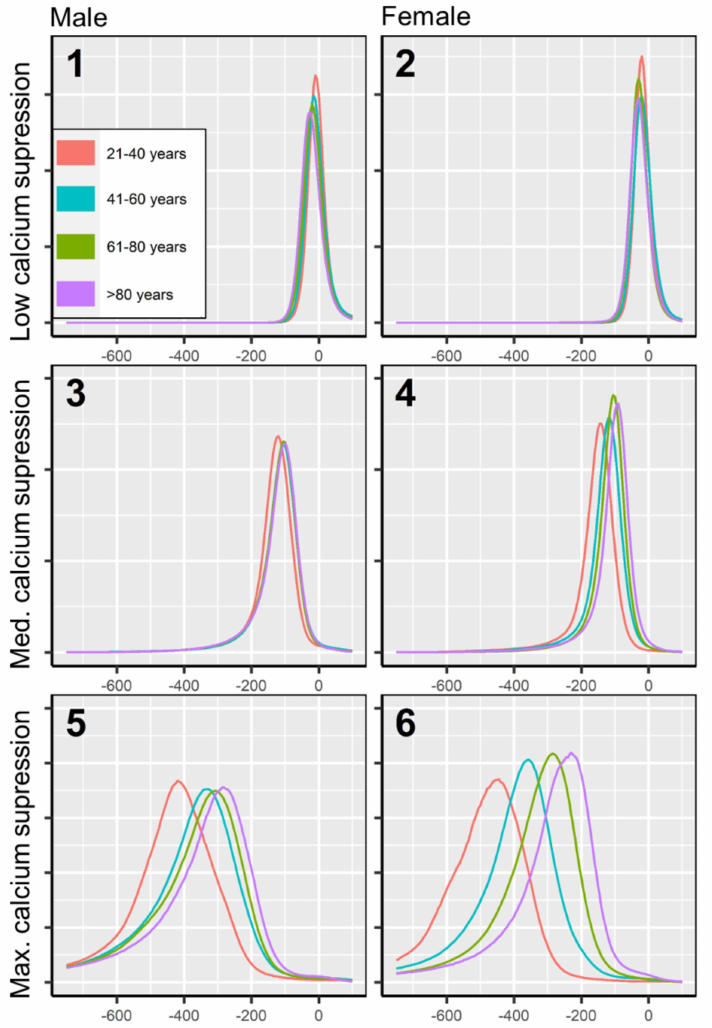
Figure 4. Attenuation histograms of physiological bone marrow in virtual non-calcium. Attenuation histograms are plotted for low, medium, and maximum calcium suppression (three columns), for males and females (two rows), and four age groups (four colors). The bone marrow space of each patient was normalized to a standard volume, to achieve an equal area under the curve